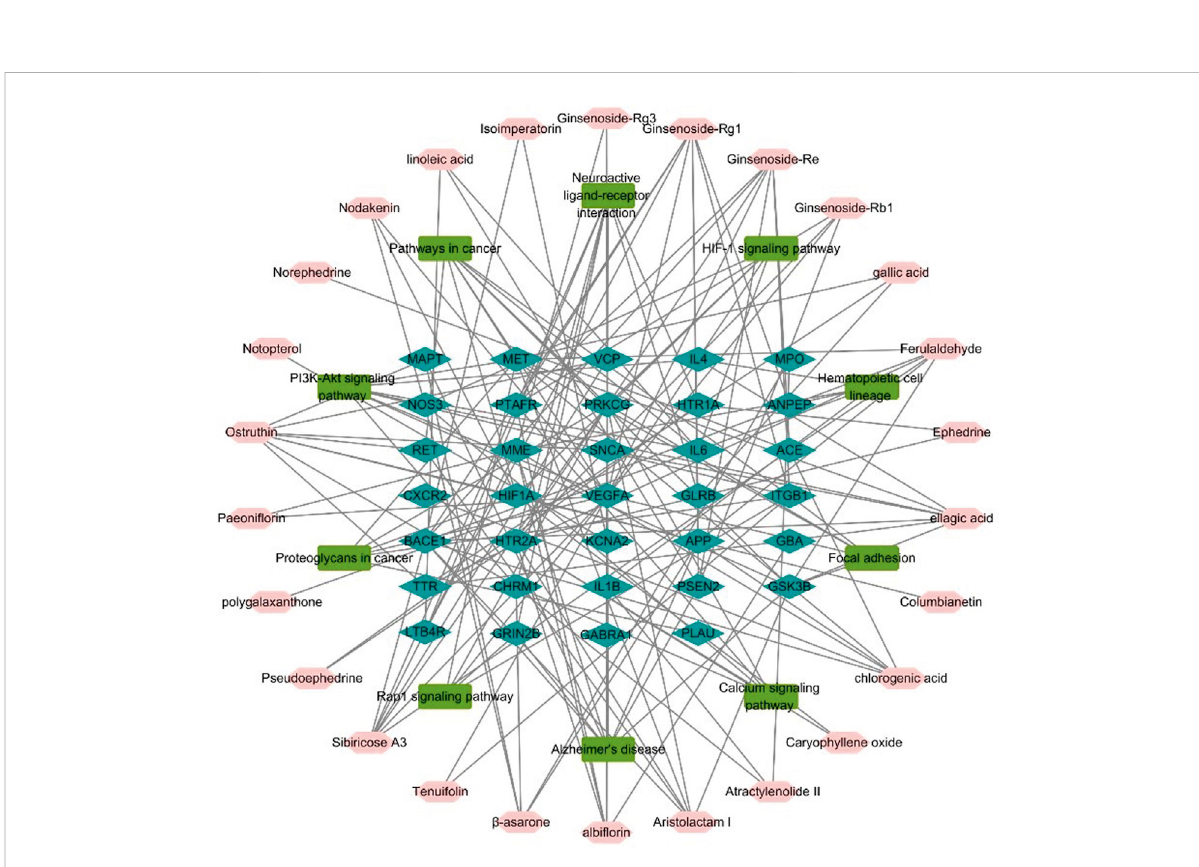
FIGURE 4 Herb component — putative molecular target - major pathway network map. Pink nodes represent active ingredients of YZD, blue nodes represent potential targets, and the green nodes indicate the involved KEGG